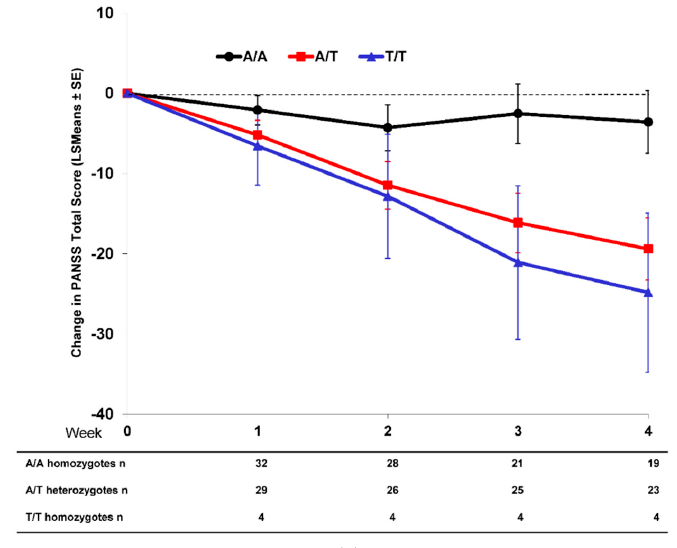
Figure 1. Cont. Figure 1.